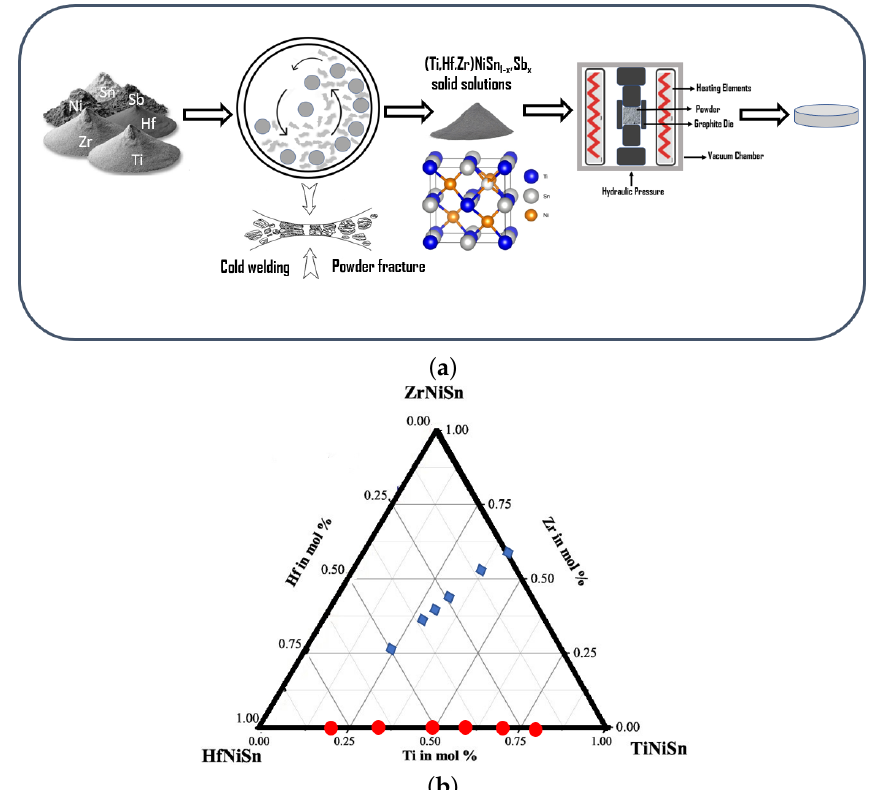
Figure 1. ( a ) Methodology of Mechanical Alloying. ( b ) Concentration diagram for selected